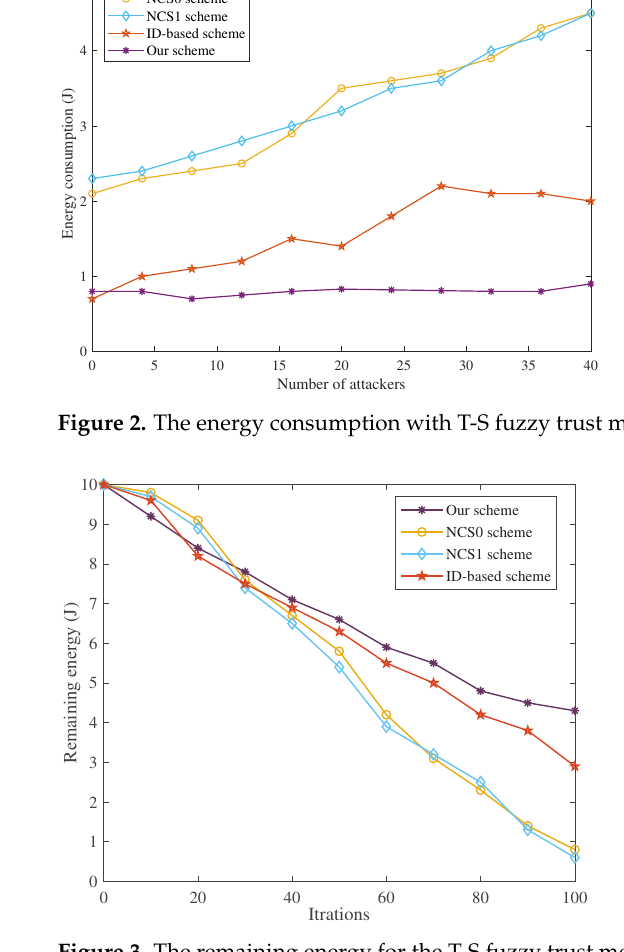
Figure 3. The remaining energy for the T-S fuzzy trust model with different iterations.